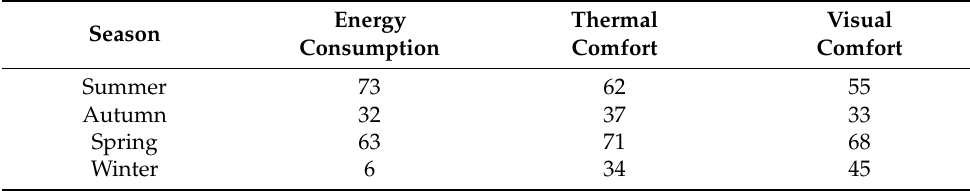
Table 2. Quantity of days with valid data.